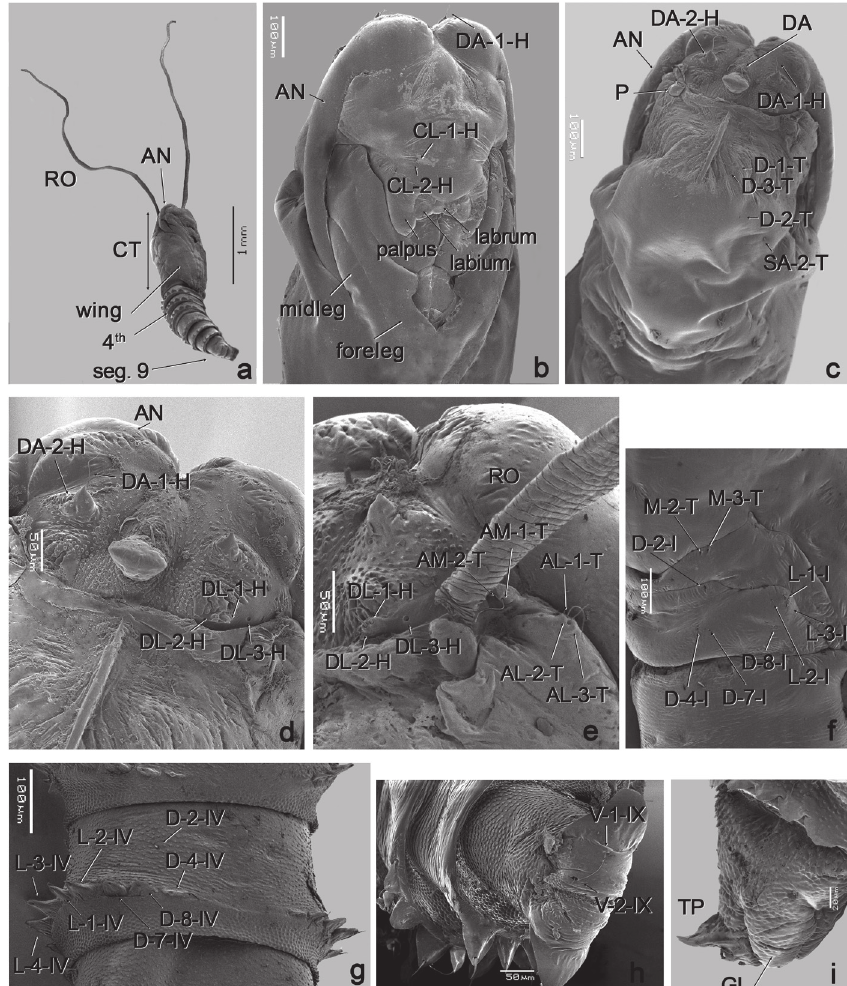
Figure 2a-i - Dasyhelea mediomunda Minaya, pupa (SEM). a-h female pupa, i male pupa; a , entire pupa (lateroventral view); b , cephalothorax (ventral view); c , cephalotorax (dorsal view); d , dorsal apotome (chaetotaxy); e , cephalotoracic sensilla and respiratory organ; f , metathoracic and first abdominal segment (chaetotaxy); g , chatotaxy of segment 4 of abdomen; h-i , segment 9. Antenna (AN); anterolateral sensilla (AL-1-T, AL-2-T, AL-3-T); anteromedial sensilla (AM- 1-T, AM-2-T); cephalothorax (CT); clypeal/labral sensilla (CL-1-H, CL-2-H); dorsal apotome (DA); dorsal apotome sensilla (DA-1-H, DA-2-H); dorsolateral cephalic sclerite sensilla (DL- 1-H, DL-2-H, DL-3-H); dorsal sensilla of first abdominal segment (D-2-I, D-4-I, D-7-I, D-8-I); dorsal sensilla of segment 4 (D-2-IV, D-4-IV, D- 7-IV, D-8-IV); dorsal setae (D-1-T, D-2-T, D-3-T); genital lobe (GL); lateral sensilla of first abdominal segment (L-1-I, L-2-I, L-3-I); lateral sensilla of segment 4 (L-1-IV, L-2-IV, L-3-IV, L-4-IV); methatoracic sensilla (M-2-T, M-3-T); pedicel (P); respiratory organ (RO); supraalar sensillum (SA-2-T); terminal processes (TP); ventral sensilla of ninth abdominal segment (V-1-IX,